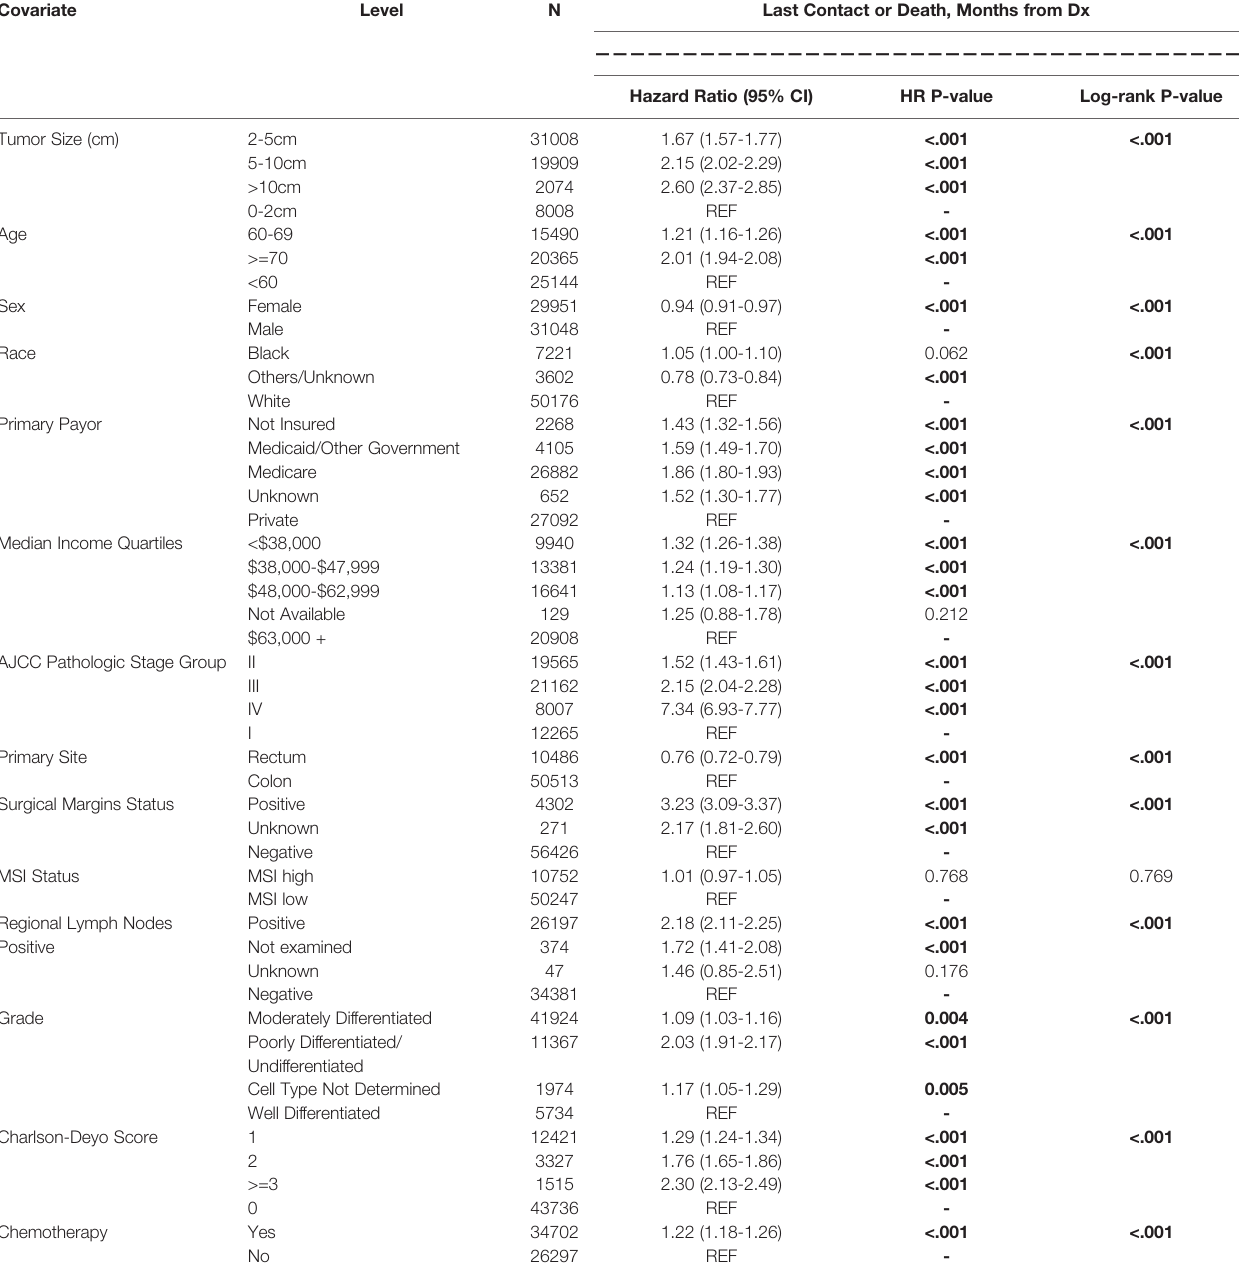
TABLE 3 | Univariate association with overall survival. REF- Reference. Covariate Level N Last Contact or Death, Months from Dx ——————————————————————————————————————